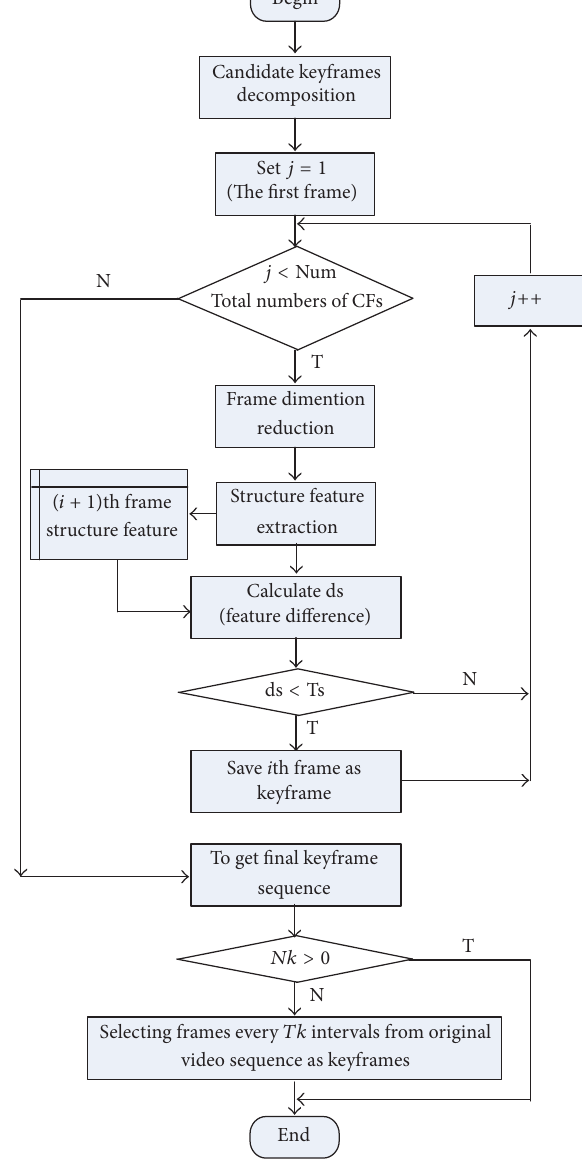
Figure 5: Flowchart of generating final key frame sequence and optimization based on key frames